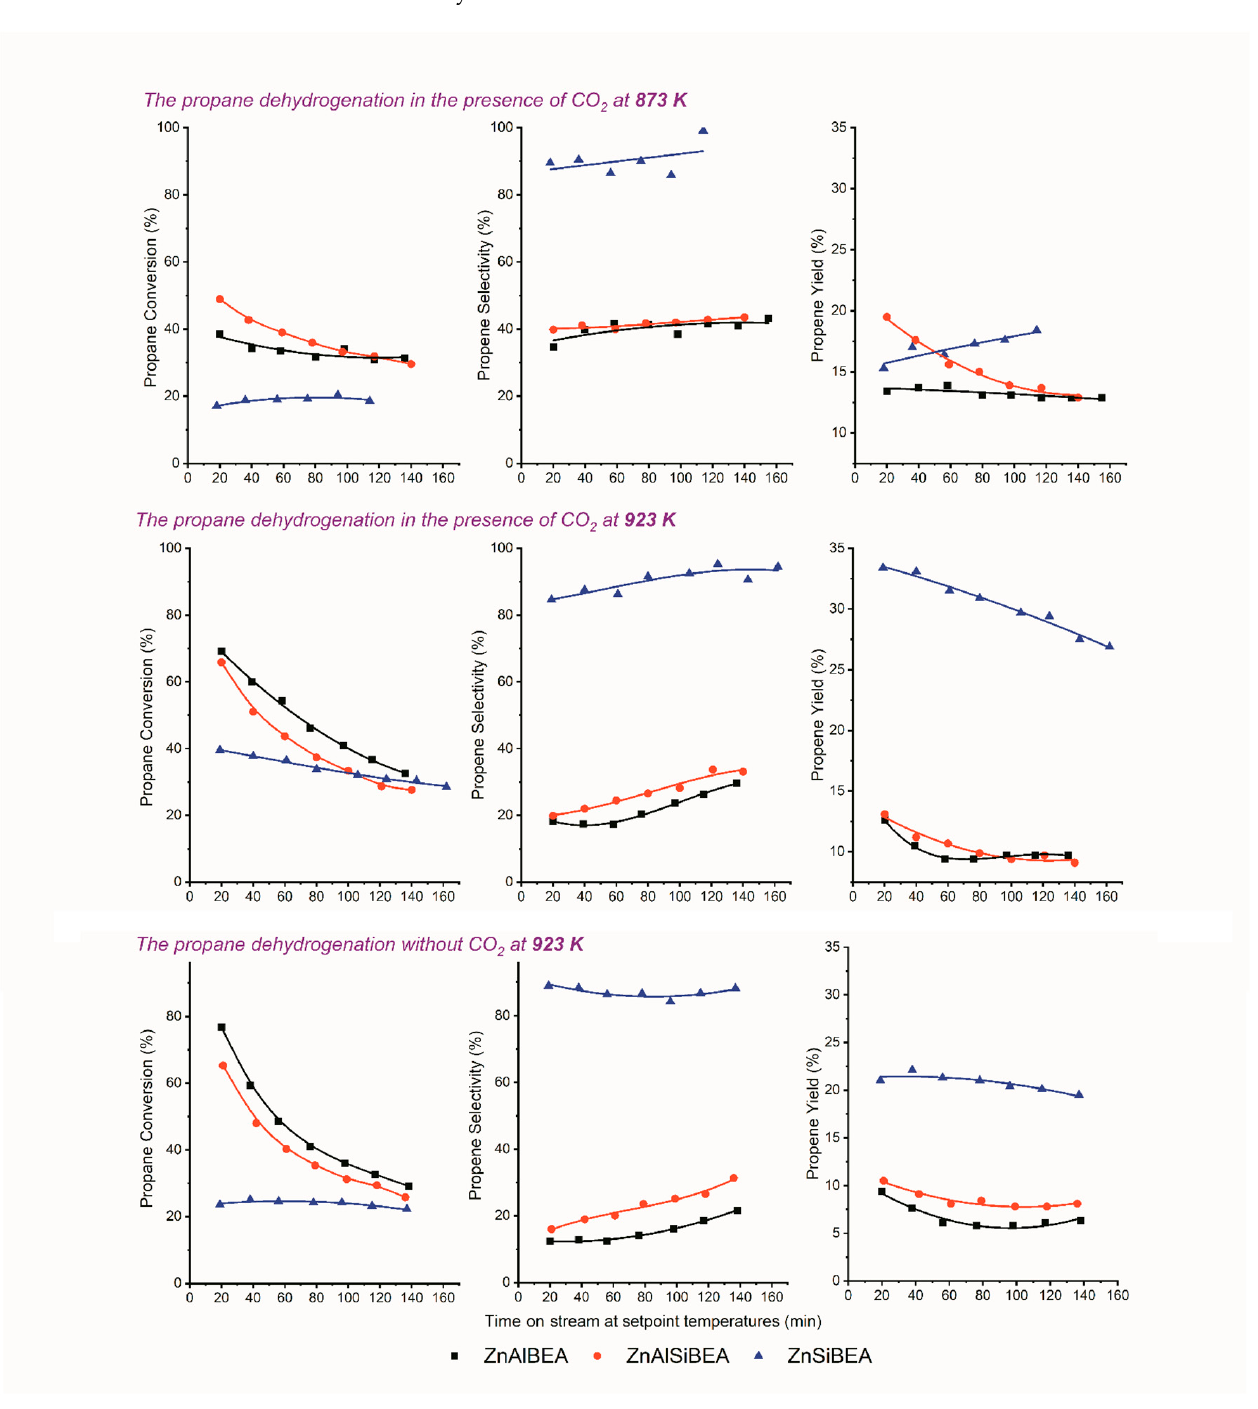
Figure 6. Indices of the propane dehydrogenation in the presence/absence of CO 2 on the Zn-BEA catalysts.